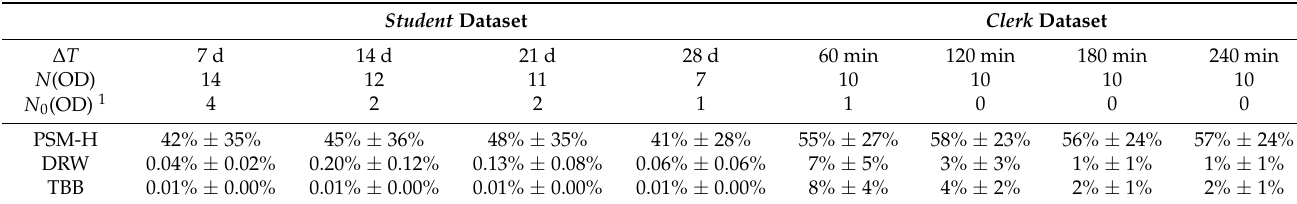
Table 2. Hit metrics of visit probability estimated by three models in two datasets. Student dataset Clerk dataset